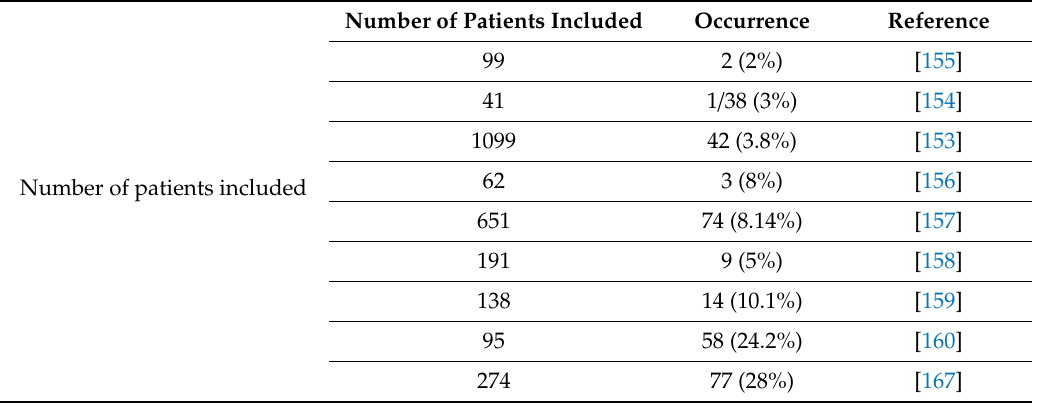
Table 4. Frequency of the most uncommon gastrointestinal symptoms displayed by SARS-CoV- 2-infected